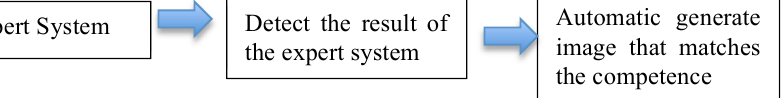
Fig. 2. Puzzle Detection Process